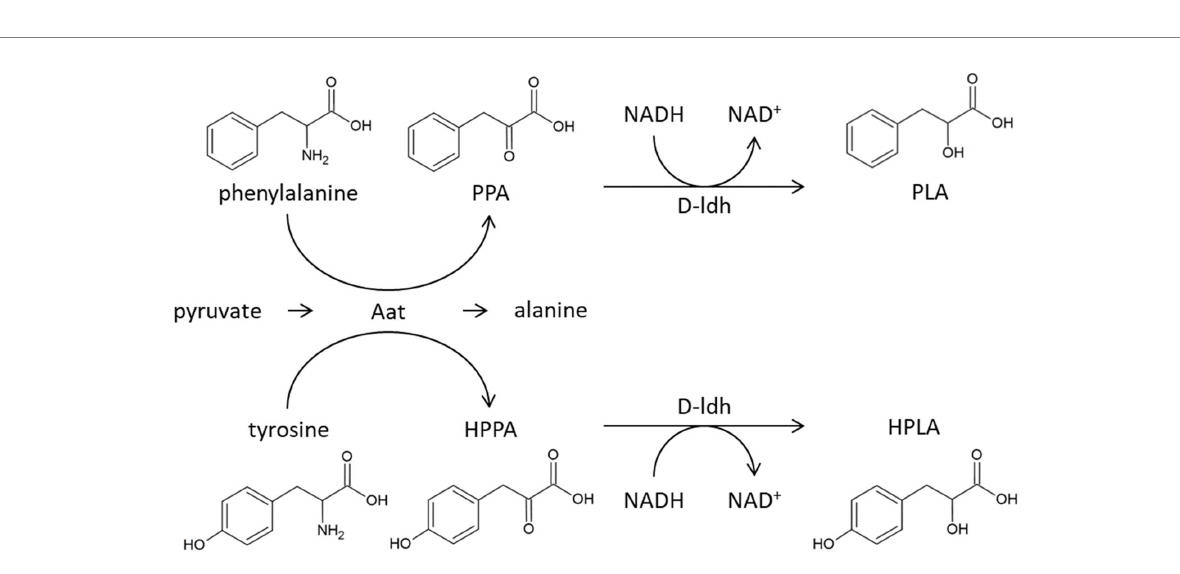
FIGURE 6 Proposed synthesis of 3-phenyllactic acid and 4-hydroxyphenyllactic acid in Pediococcus acidilactici . Firstly, phenylalanine and tyrosine are deaminated through the aminotransferase Aat (GenBank Protein WP_159211138), forming phenylpyruvic acid (PPA) and 4-hydroxyphenylpyruvic acid (HPPA), respectively. Then the keto acids are reduced by the D-lactate dehydrogenase (GenBank Protein WP_152689015) reaction, forming 3-phenyllactic acid (PLA) and 4-hydroxyphenyllactic acid